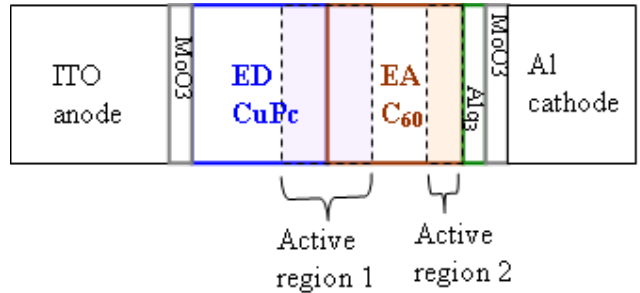
Figure 5. Schematic representation of an OPVC with localization of the active